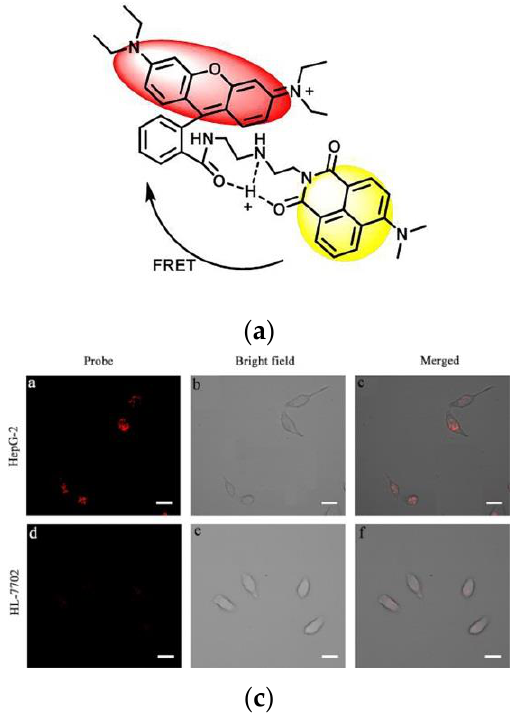
Figure 13. ( a ) The proposed mechanism of RBN for sensing H + ; ( b ) Fluorescence spectra of RBN at different pH values; ( c ) CLSM images of HepG-2 cells and HL-7702 cells incubated with RBN. Reproduced with permission from [74]. Copyright 2017 Elsevier B.V. on behalf of Chinese